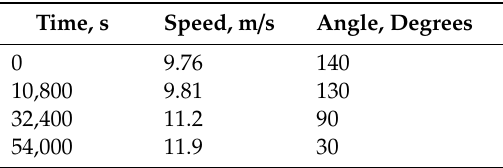
Table 2. Typhoon parameters.